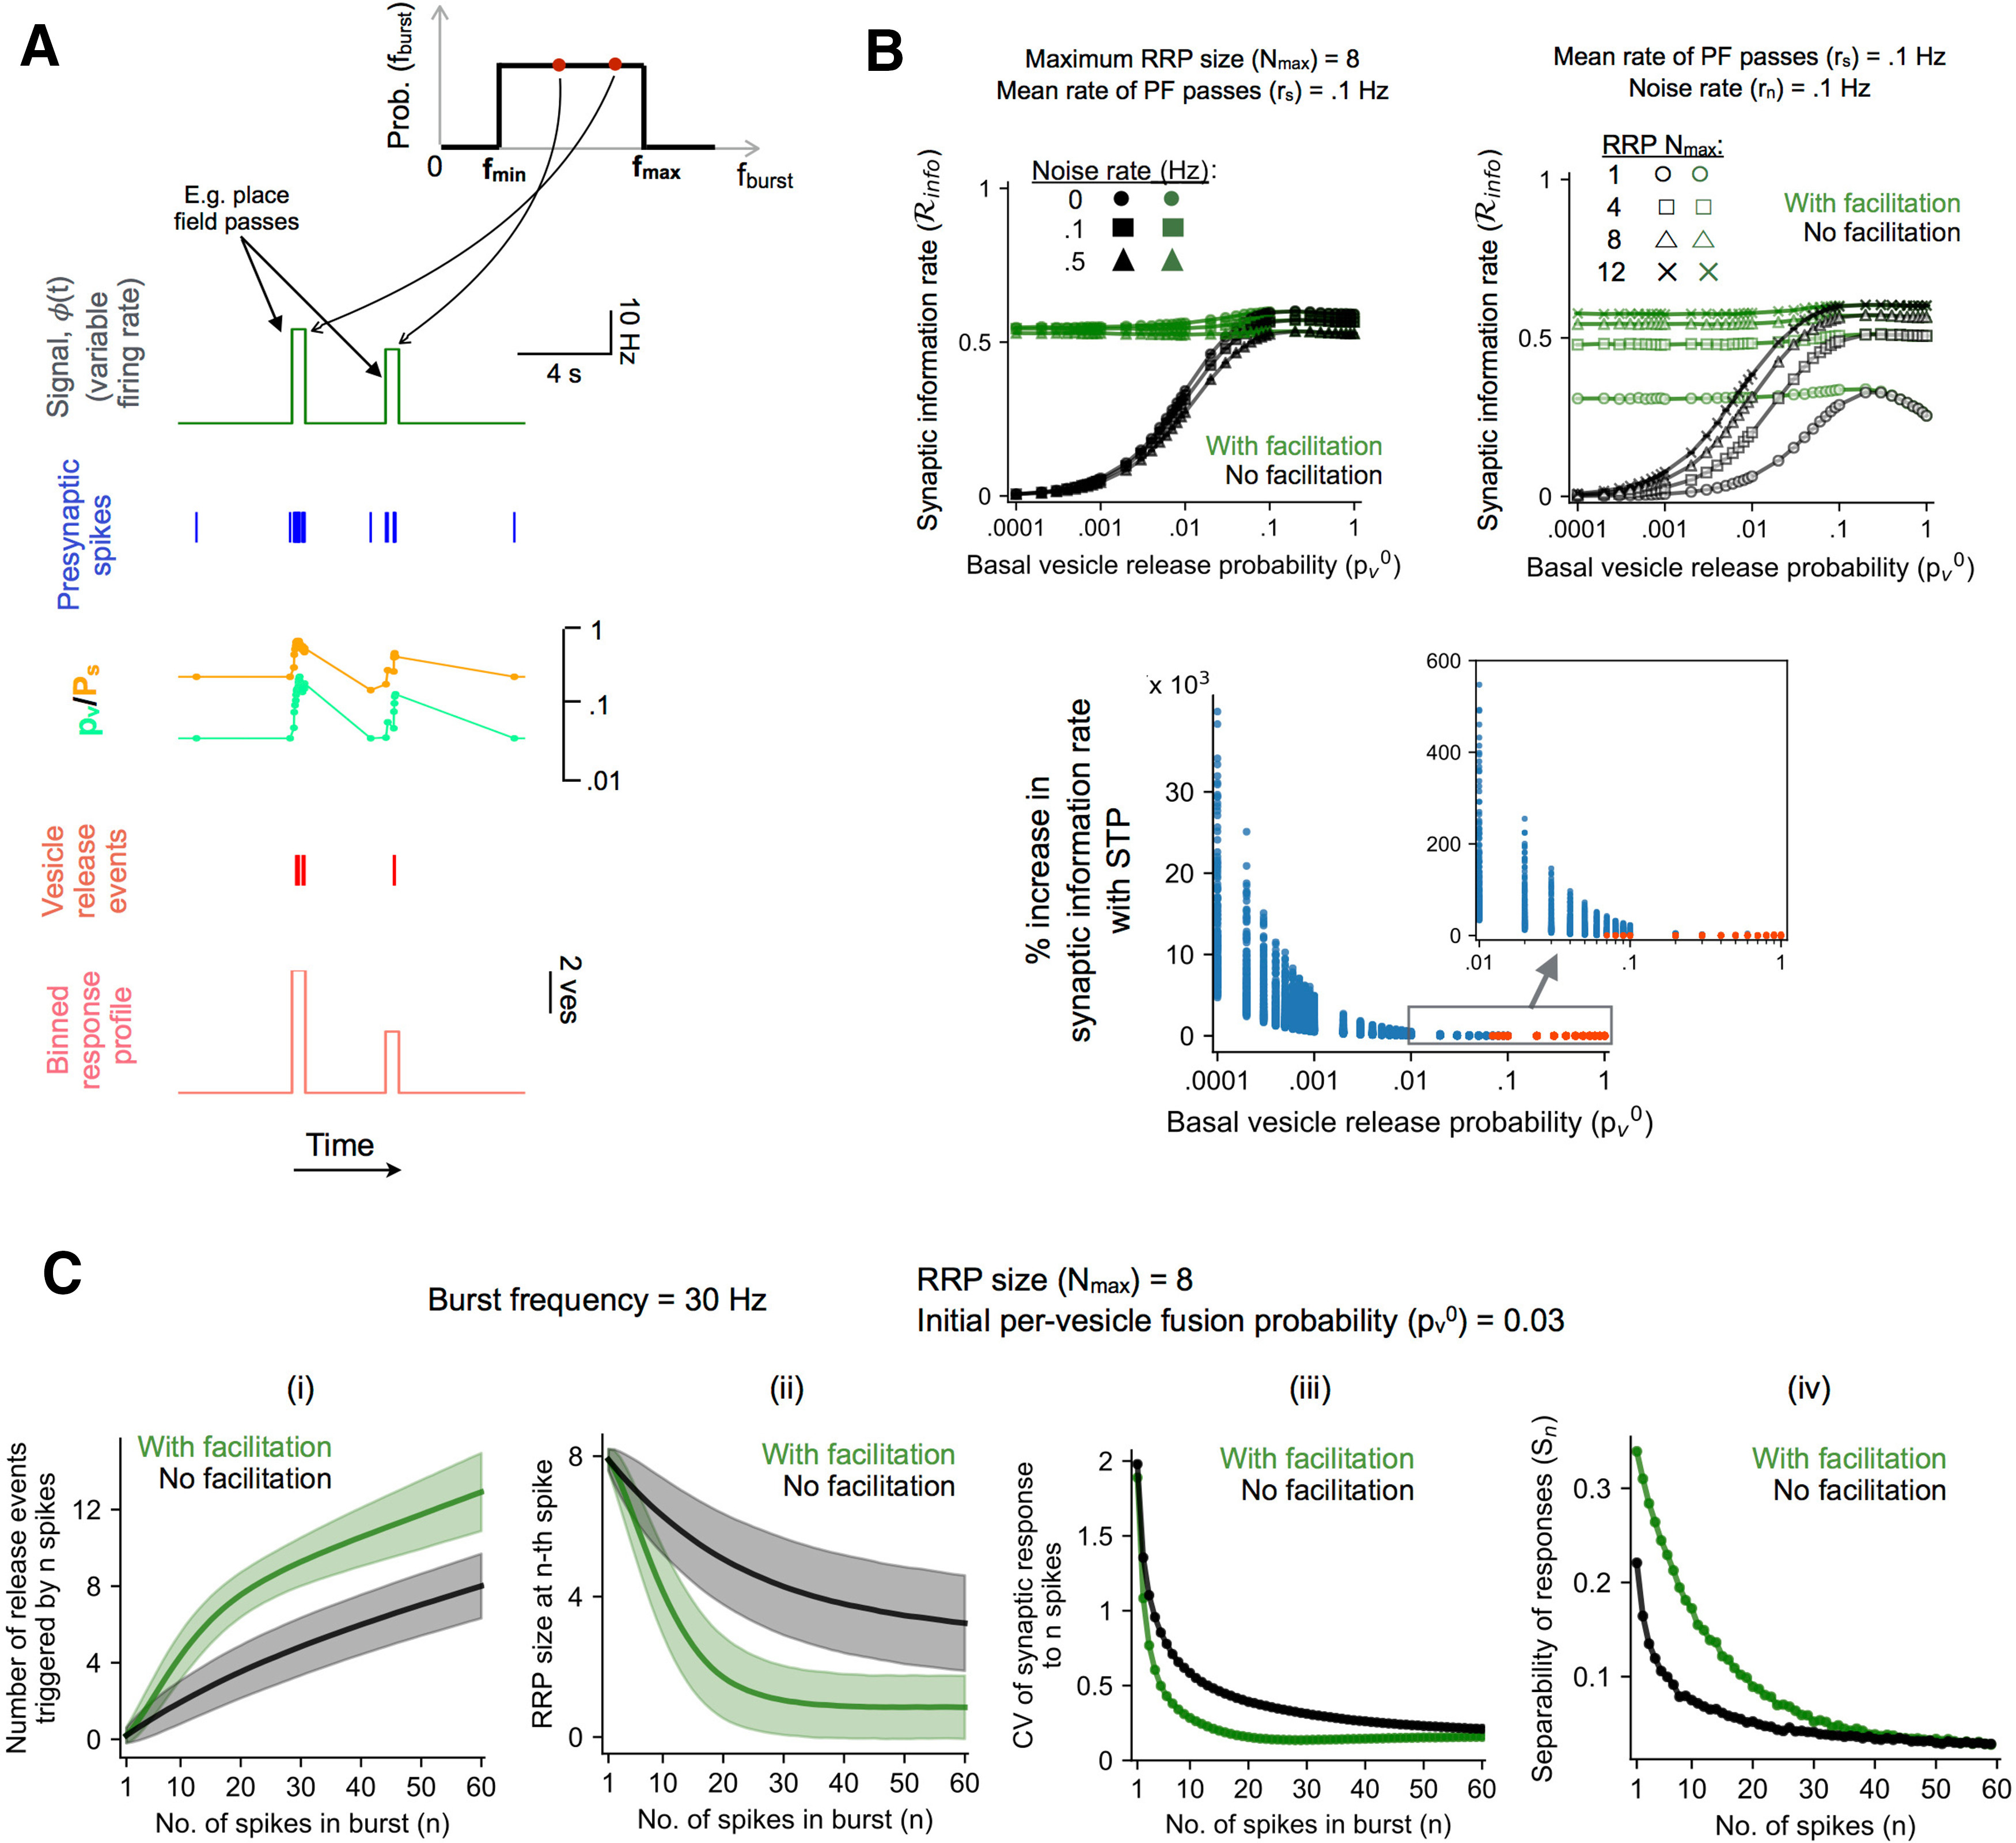
Elevated transmission of presynaptic information with STP of vesicular release. A, Time trace illustrating the conversion of an input signal [ϕ(t)] to a sequence of synaptic release events governed by STP. For this example, Ps0= 0.2, Nmax = 8, and rs = rn = 0.1 s–1. The uniform distribution of spiking frequencies from which individual burst instances are randomly sampled is shown in the top right corner. B, top left, Time-averaged rate of information carried by synaptic release events (Rinfo) as a function of the basal per-vesicle fusion probability (pv0) for a synapse with STF (green curves) and an equivalent non-facilitating synapse (black curves). Different markers indicate different noise levels. (Results shown as mean ± SEM over 20 independent simulations; Nmax= 8 and input rate rs = 0.1 s.) Top right, Synaptic information transfer rates with STP (green curves) and without facilitation (black curves) for different numbers of available vesicles (different markers). (Results shown as mean ± SEM over 20 independent trials; rn = rs = 0.1 s–1.) Error bars being smaller than the marker size are not visible. Bottom, Enhancement of synaptic information transmission with facilitation summarized as a distribution of relative changes (% difference of means relative to the static synapse) over a biologically relevant range of input/model parameters (for details, see Materials and Methods). Inset shows a magnified view of the 0.01 ≤pv0≤ 1 interval. Color coding indicates statistical significance of pairwise differences (blue: significant at FDR <0.001 level, red: not significant). C, Synaptic response (i) and progressive depletion of the readily releasable vesicle pool (ii) as functions of the number of input spikes for a synapse with STF (green) and lacking facilitation (black). Response fluctuations are quantified in terms of the CV of number of release events (iii) and separability of responses to bursts differing in size by a single spike (iv). Results in i, ii shown as mean ± SD (1000 independent trials); Ps0 = 0.2, Nmax = 8, and spikes are Poisson-distributed with mean frequency of 30 Hz.